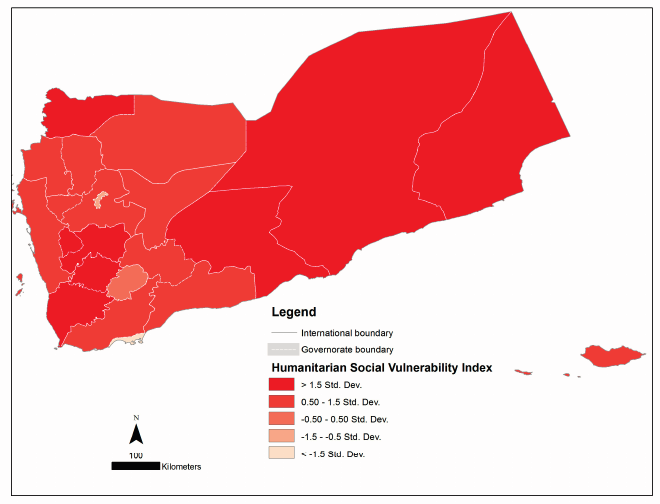
Figure 6. 2015 Population in needs in governorates in Yemen.